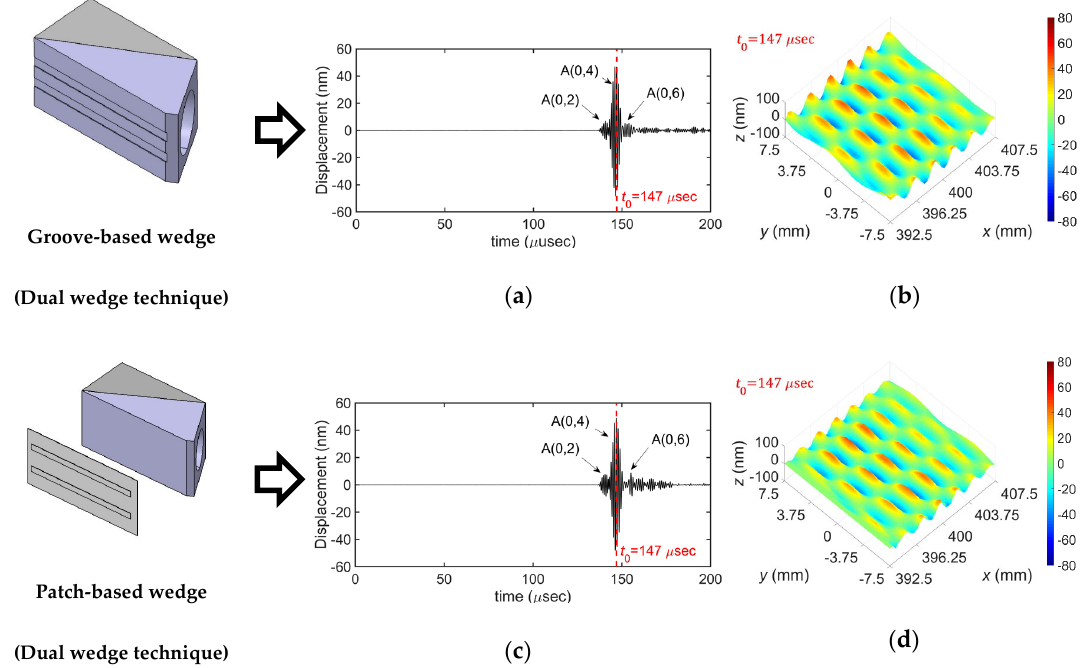
Figure 13. Experimental results for the selective generation of the A(0,4) mode: ( a ) time history and ( b ) displacement distribution obtained by using the groove-based wedge; ( c ) time history and ( d ) displacement distribution obtained by using the patch-based wedge; time histories were picked up at side edge at 400 mm away from the excitation source.